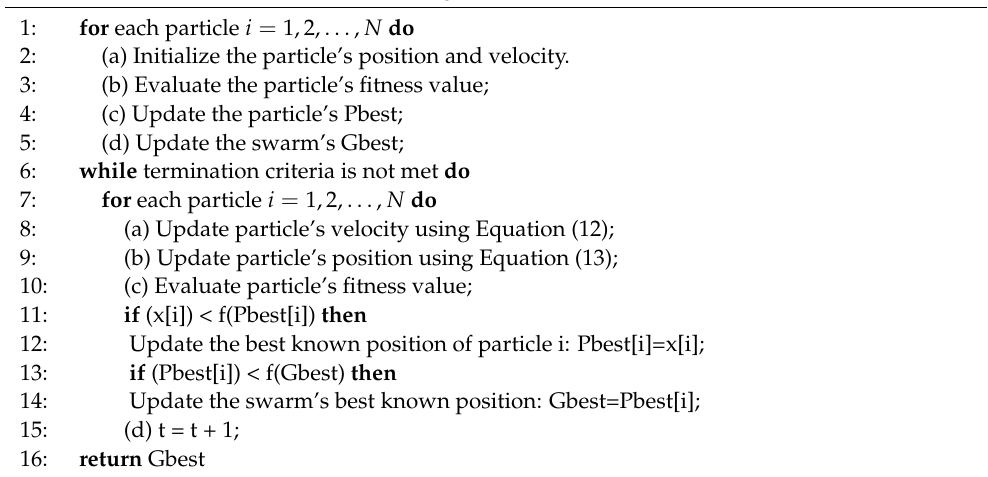
Algorithm 1 Procedure of standard PSO